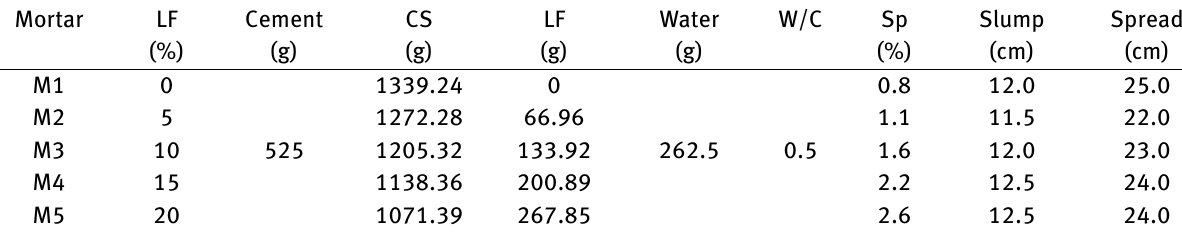
Table 4: Composition and designation of the cement grout.